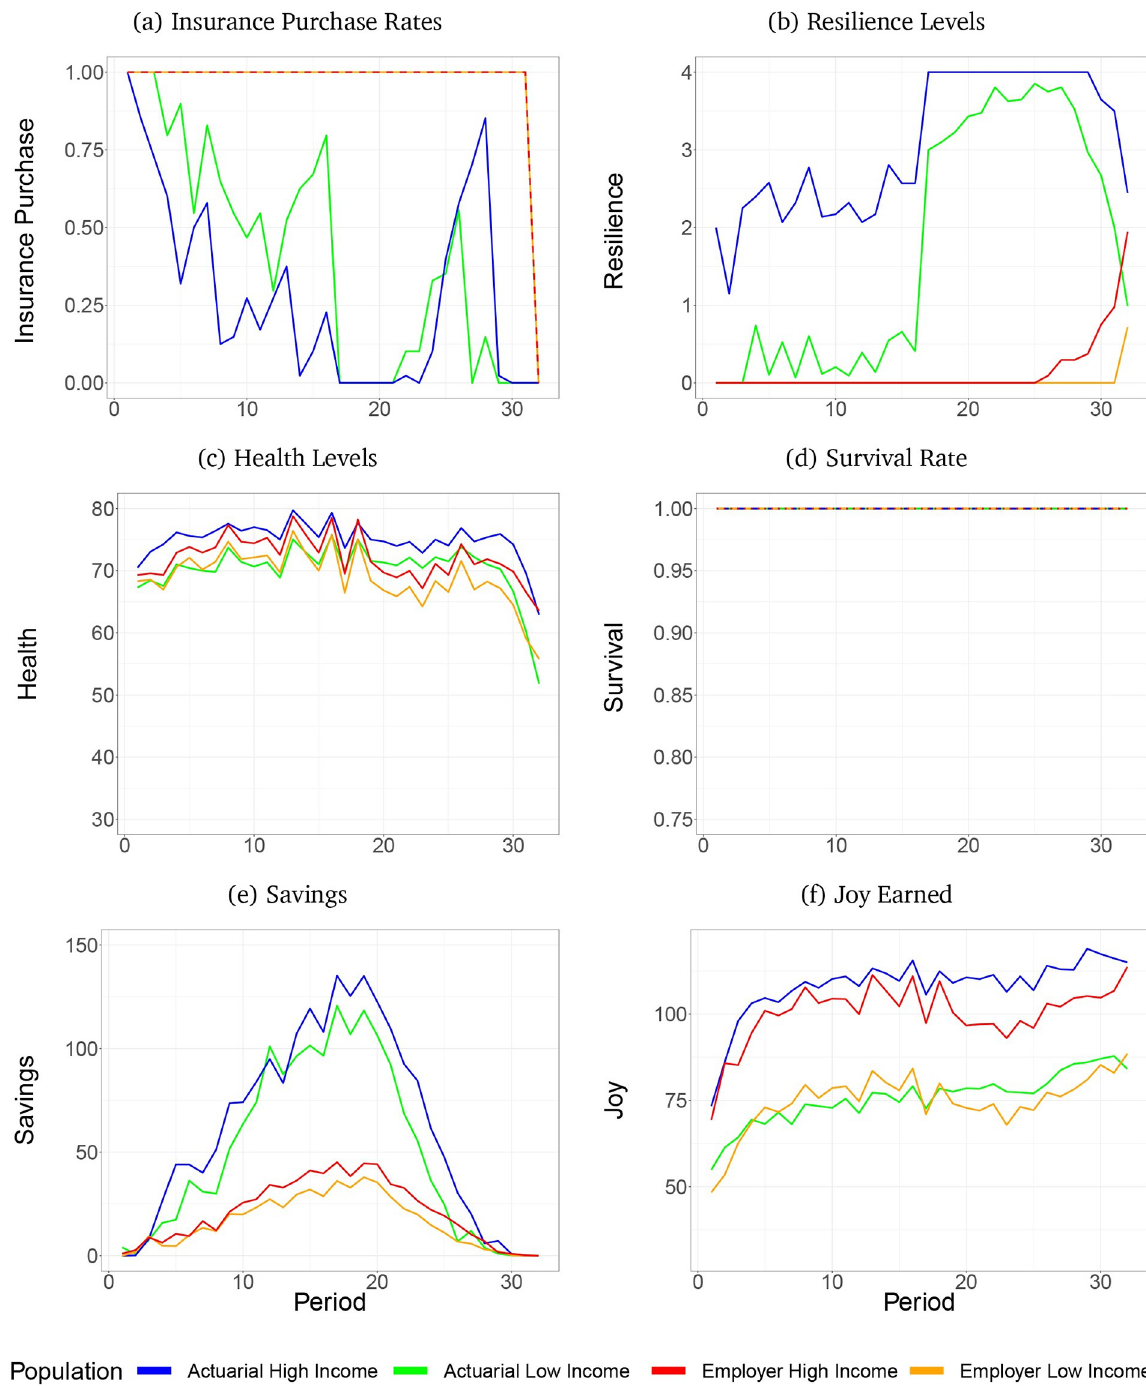
Fig 2. Results from dynamic program. Includes panels: (a) Insurance purchase rates, (b) Resilience levels, (c) Health levels, (d) Survival rate, (e) Savings, (f) Joy earned.